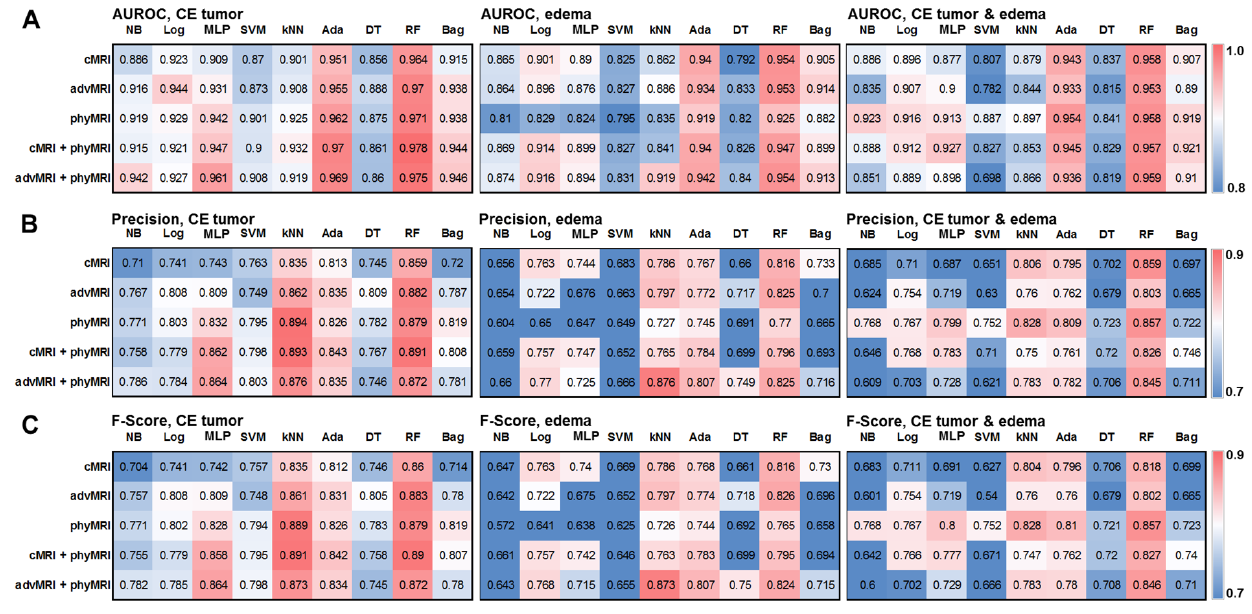
Figure 2. Heatmaps depicting ( A ) the area under the receiver operating characteristic (AUROC) curve, ( B ) precision, and ( C ) F-score for the five MRI data set combinations (conventional MRI (cMRI), advanced MRI (advMRI), physiological MRI (phyMRI), cMRI combined with phyMRI data, and advMRI combined with phyMRI data) and the nine ML algorithms in contrast-enhancing (CE) brain tumor (left), peritumoral edema (middle), and the combined area of CE tumor and edema (right), respectively. The color codes are listed on the far right. NB = naïve Bayes, Log = logistic regression, MLP = multilayer perceptron, SVM = support vector machine, kNN = k-nearest neighbors, Ada = adaptive boosting (AdaBoost), DT = decision tree, RF = random forest, and Bag = bootstrap aggregating (bagging). Table 3. Diagnostic performance of the four selected ML classifiers and the human readers in the learning/validation cohort. F ‐ Score